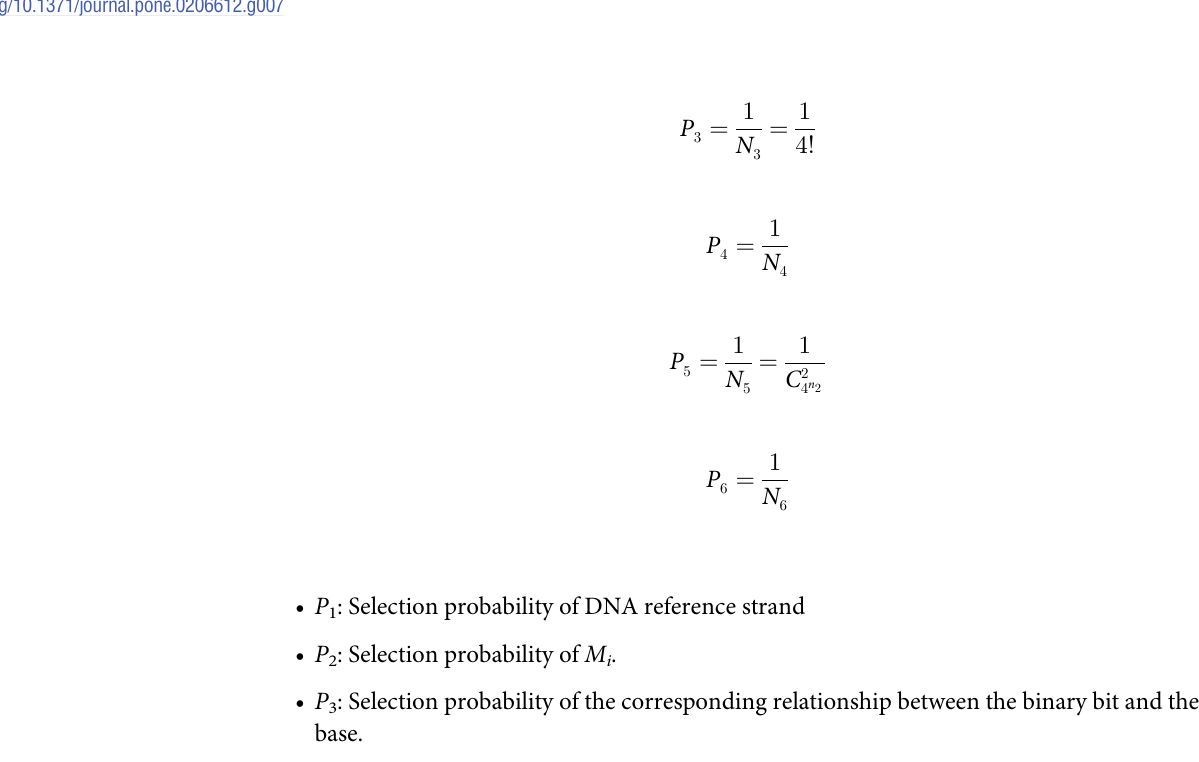
Fig 7. Scatter diagram with 300 iterations: (a) is the iteration value displayed on the 300 times with g = 0.501, μ = 3.68; (b) shows the iteration value displayed 300 times with g = 0.50100000000001, μ = 3.6800000000001.